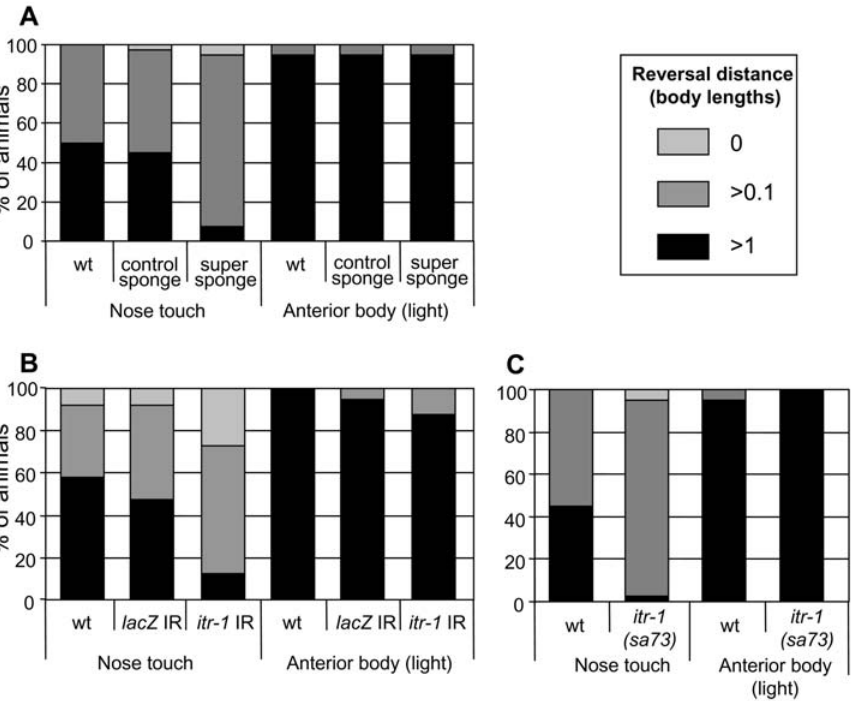
Figure 2. IP 3 and itr-1 function in the aversive response to nose touch. The reversal response (measured in worm lengths) of animals exposed to nose touch or light anterior body touch. (A) Animals expressing IP 3 sponge derivatives under the control of the unc-119 promoter. (B) Animals expressing dsRNA under the control of the unc-119 promoter. IR, inverted repeat. (C) Animals carrying the itr-1(sa73) loss-of-function allele. All three methods of disrupting ITR-1 function significantly disrupt the nose touch response in comparison to wt animals (P , 0.001, Chi-squared test, in each case). The control sponge (A) and lacZ control IR (B) do not disrupt the response (P . 0.05).